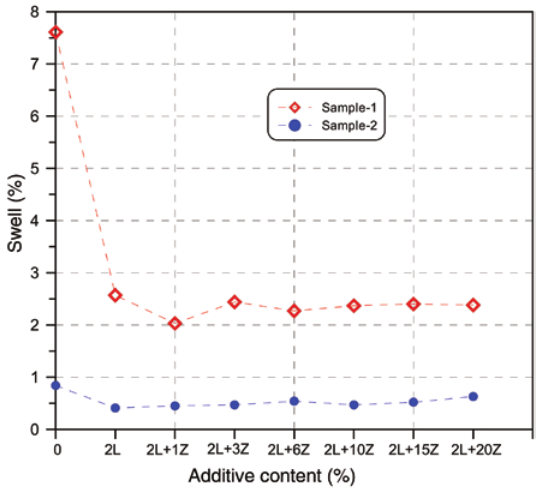
Figure 4: Relationship between additive content and swell percent- age of the soil samples.